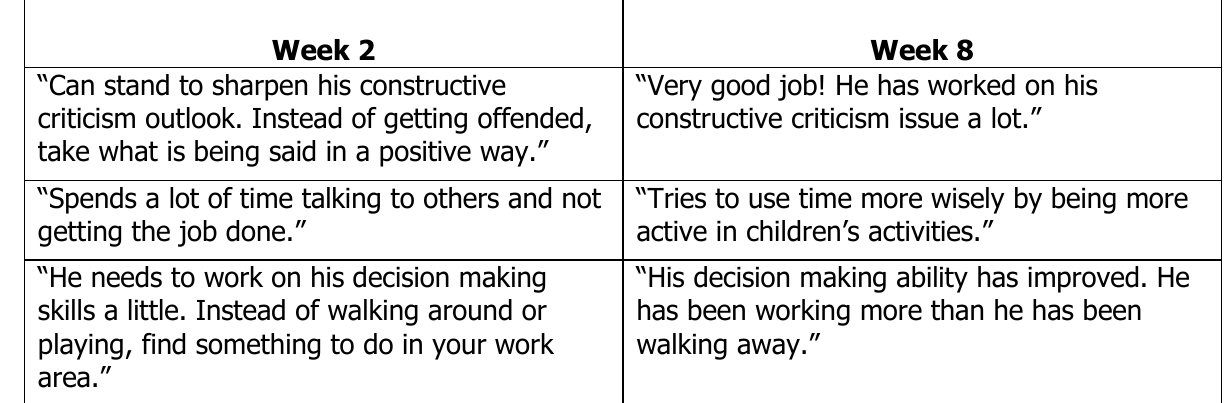
Comparison of Supervisors’ Early and Late Performance Appraisals of Workforce